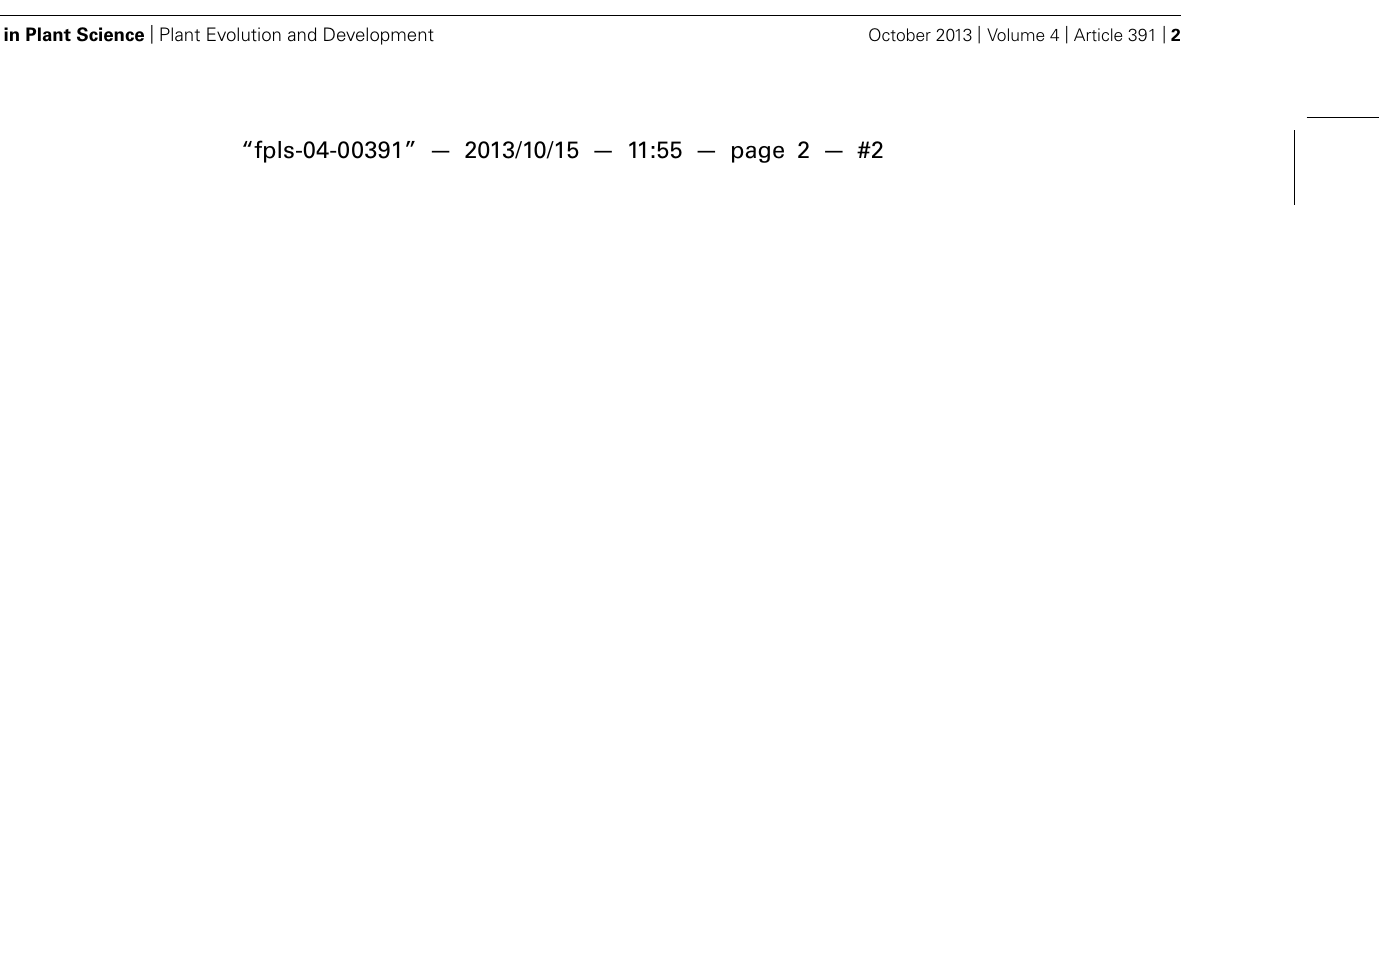
placenta. (C) Longitudinal mid-section of fruit. Note the major vascular bundles (arrowheads) of fruit. CP, central placenta; PP, peripheral placenta; OP, outer